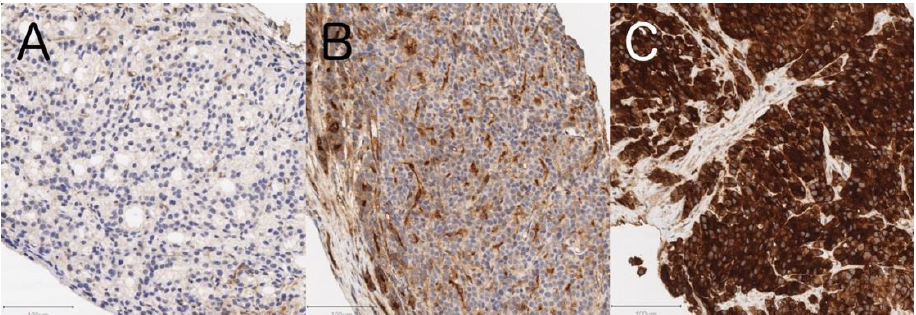
Figure 2. Representative histologic micrographs of immunohistochemical staining for GGT in prostate cancer cells showing ( A ) negative to weak (n = 6; 21%), ( B ) moderate (n = 12; 41%), and ( C ) strong (n = 11; 38%) GGT expression. Scale bars: 100 μm. Table 5. Clinicopathological characteristics of 29 de novo mCSPC men according to GGT expression status. Characteristic at Diagnosis